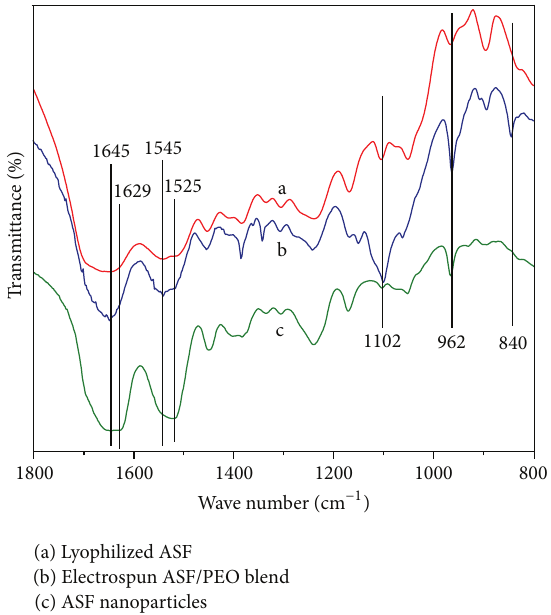
Figure 4: FTIR spectra of (a) lyophilized ASF, (b) electrospun ASF/PEO blend, and (c) ASF microparticles.